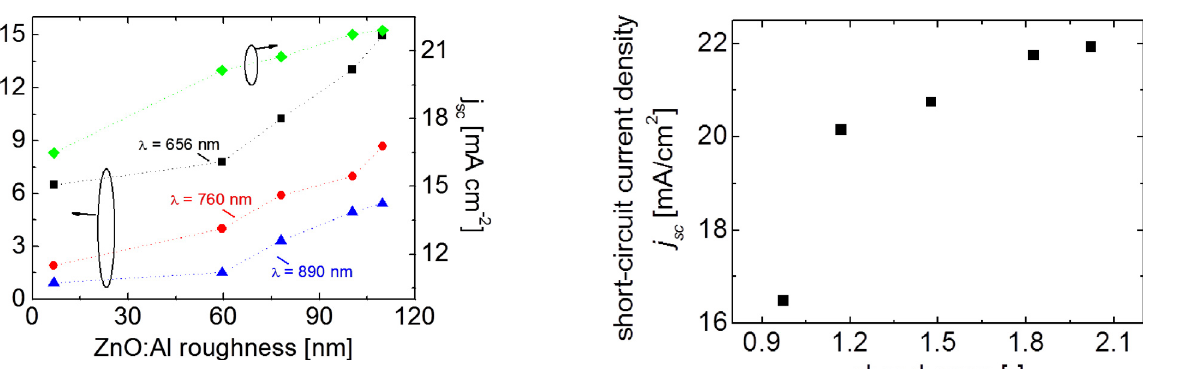
Fig. 3. Effective absorption coefficient α eff and short-circuit solar cell current density j sc as a function of RMS roughness of the different ZnO:Al layers. The thickness of the cells is ∼ 1.4 μ m.